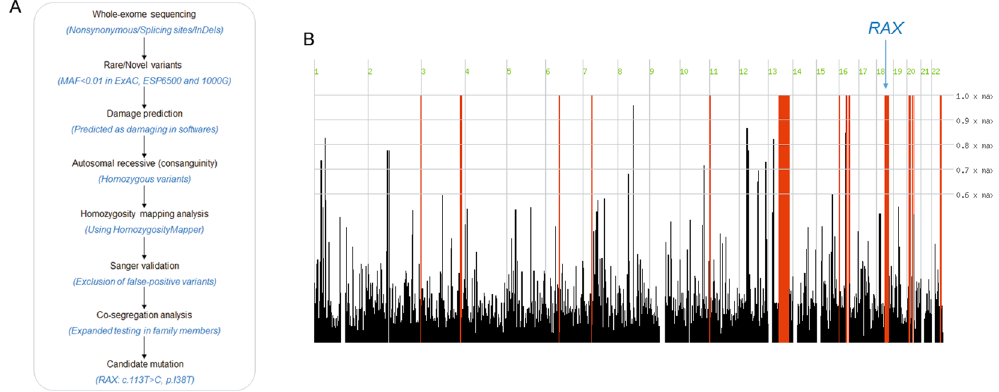
Figure 2. The workflow diagram and homozygosity mapping analyses. ( A ) The workflow diagram. ( B ) The results of homozygosity mapping analyses.